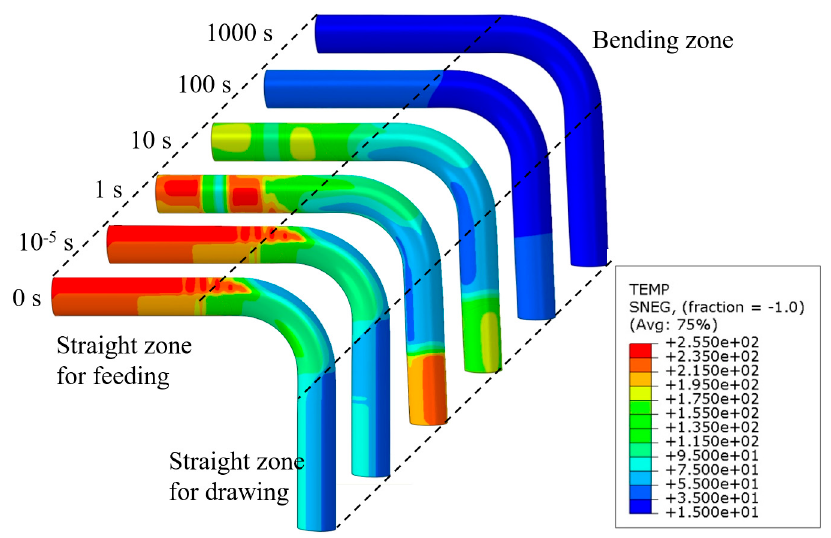
Figure 8. Residual stress distribution of bent tube before unloading under 90° bending at 250